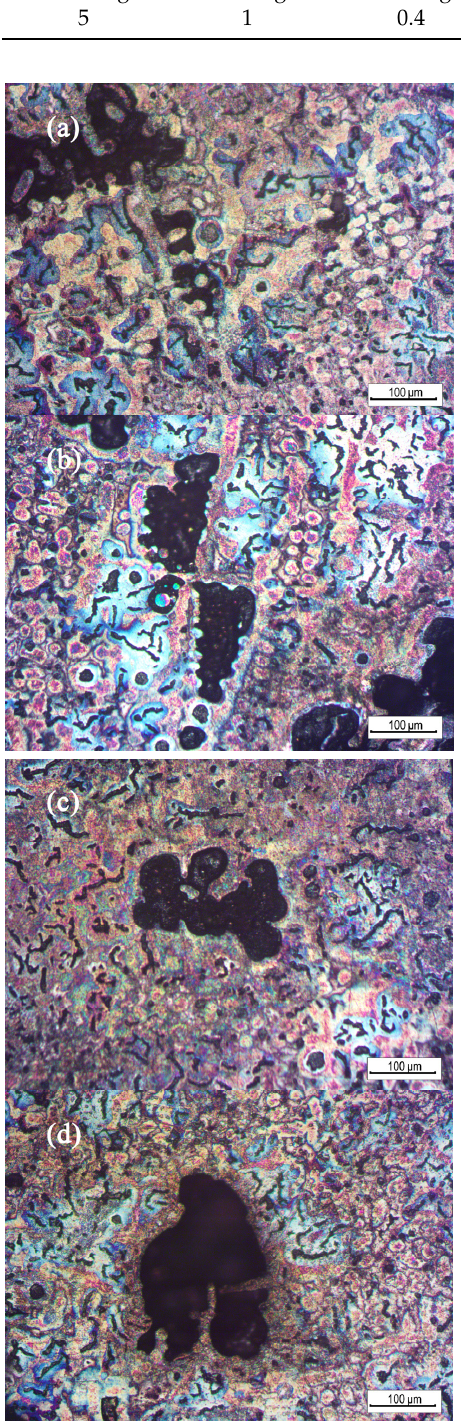
Table 4. Parameters of a hot alkali corrosion solution and etching process. wt.%